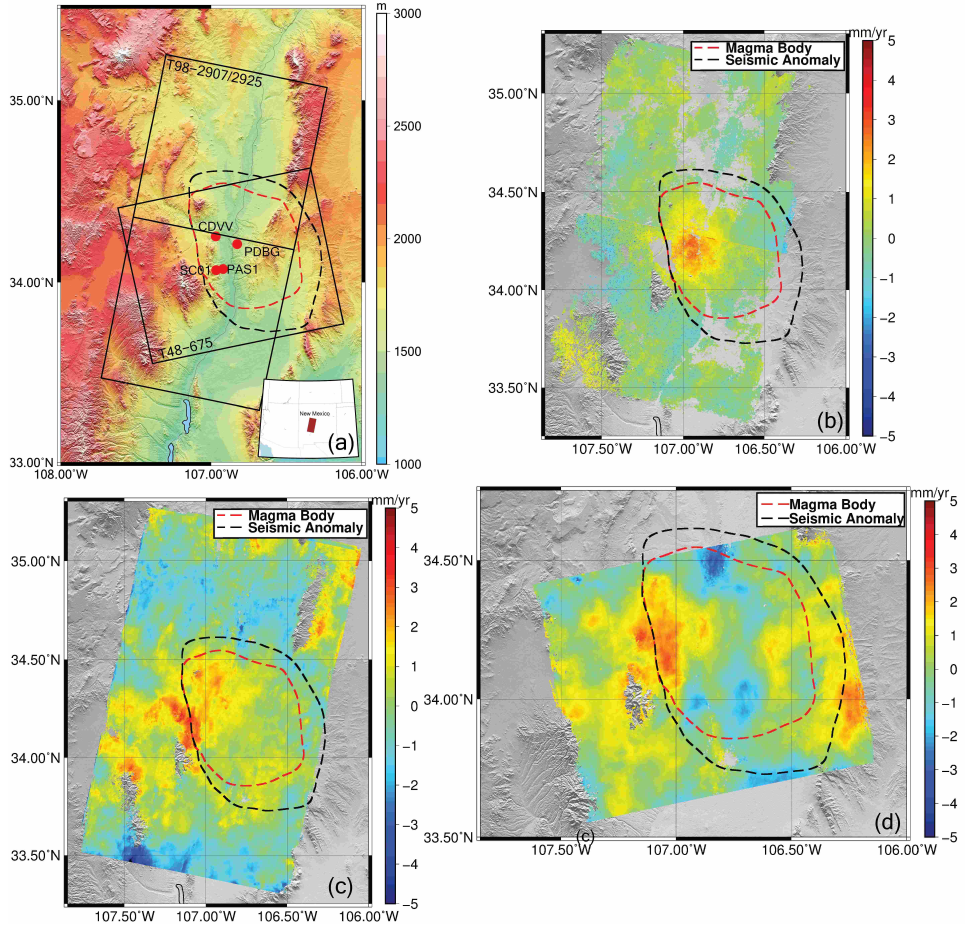
Figure 9. ( a ) The ERS and Envisat satellites share the same track and frame numbers (98-2907/2925) in descending orbit. The ascending orbit of the Envisat satellite covers the study area with frame 675 of track 48. The black dashed line represents the so-called Socorro Seismic Anomaly and the red dashed line represents the Socorro Magma Body defined by [47]. Deformation rates were calculated over Socorro Magma Body (SMB) by using ERS-1/2 and Envisat data. ( b ) The deformation rate map derived from frames 2907 and 2925 of descending track no. 98 of the ERS-1/2 data acquired between 1992–2007. ( c ) The deformation rate derived from Envisat descending scenes of the same track and frame acquired between 2006–2011. ( d ) The deformation rate map derived from Envisat frame 675 of ascending track no